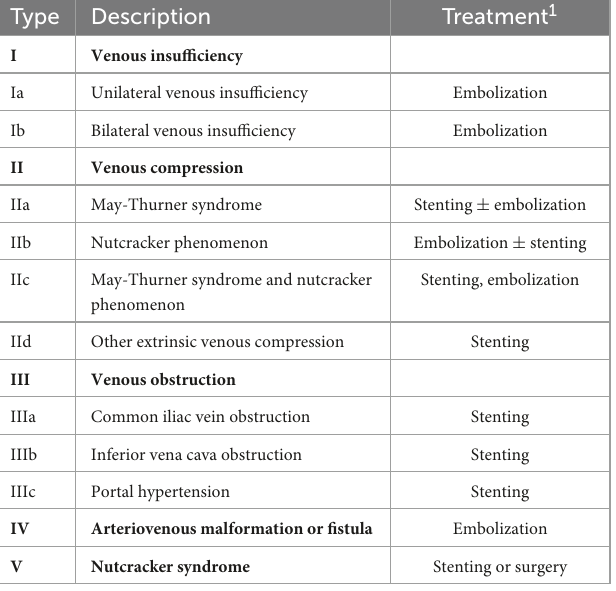
TABLE 2 Proposed management-oriented classification of pelvic venous disorders (PeVD), divided into five types. Each type or subtype is associated with a specific treatment.